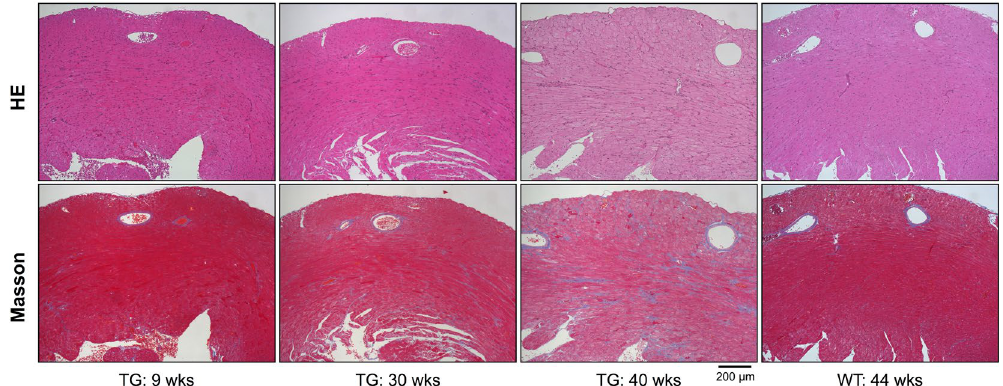
Figure 3. Fibrotic changes in Kir6.1TG mouse heart. Representative Hematoxylin and Eosin staining and Masson Trichrome staining of the anterior wall of the left ventricle section from WT and Kir6.1TG (line 673) mice (n = 2–3 mice per group). Aged Kir6.1TG (40 weeks) heart increases in fibrosis compared to the WT (44 weeks), and younger Kir6.1TG (9 and 30 weeks) hearts. Scale bar: 200 µ m, original magnification × 100.